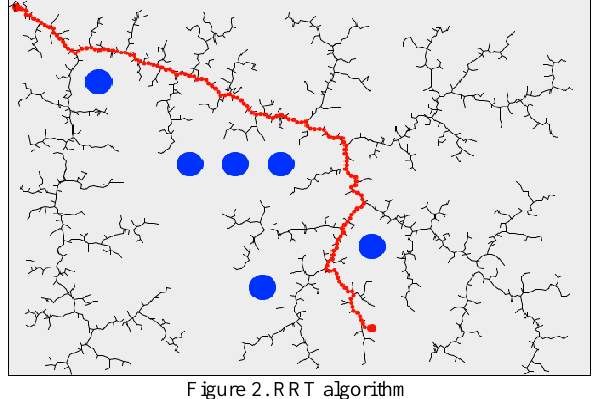
Figure 2. RRT algorithm